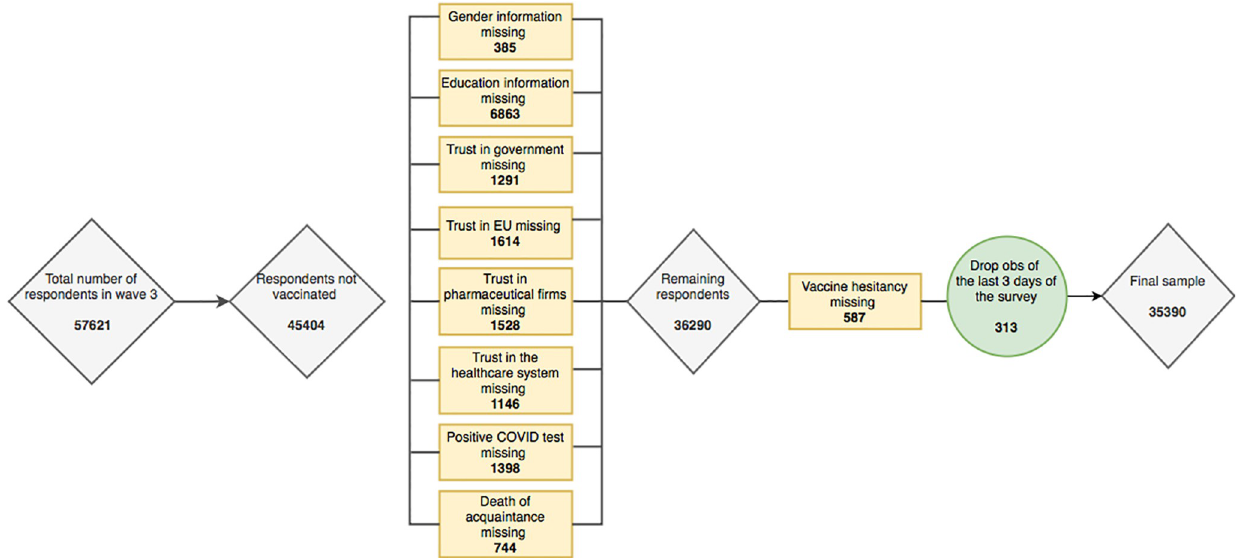
Fig 1. Sample selection. Notes: The initial sample of 57,621 respondents is obtained by eliminating those individuals who declare themselves to be older than 100 or who have missing age information.